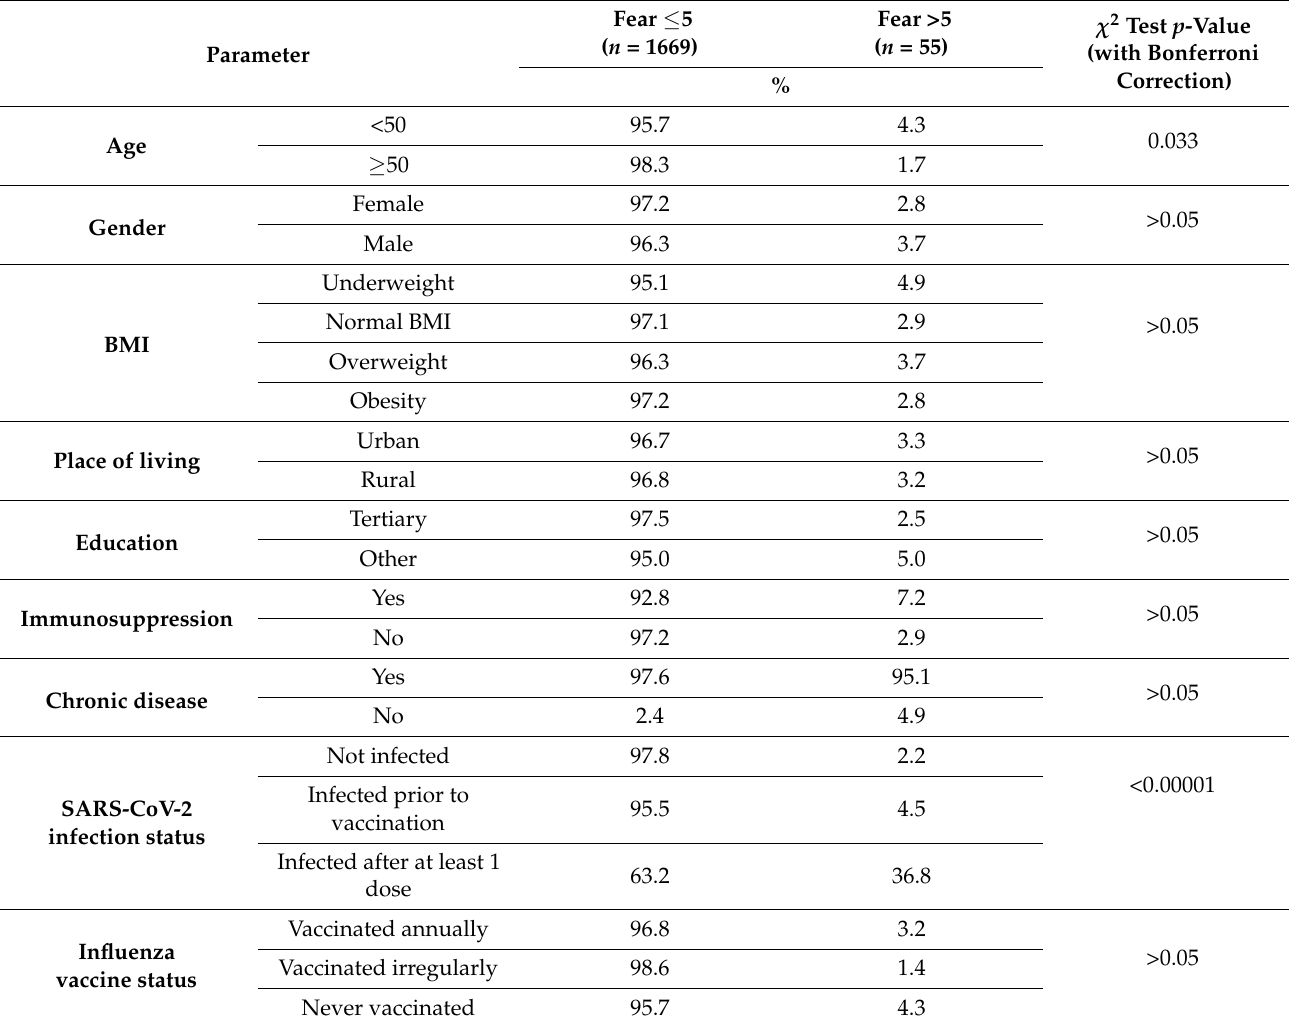
Table 3. The percentage of individuals in the studied group ( n = 1724) with the level of fear of >5 (in 1–10 Likert-like scale) of the potential booster COVID-19 vaccine in relation to different demographical